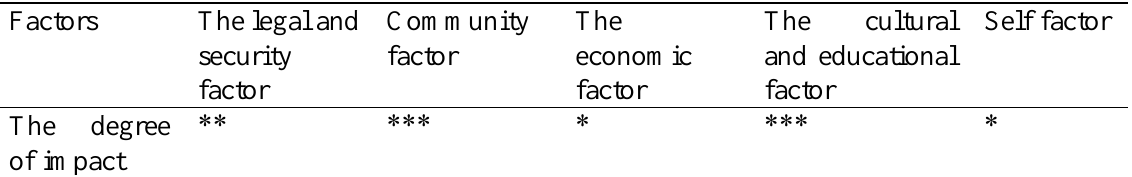
Table 10. The effect of broken windows theory experiments on the study site / source: the researcher in cooperation with the concerned authorities and official departments.